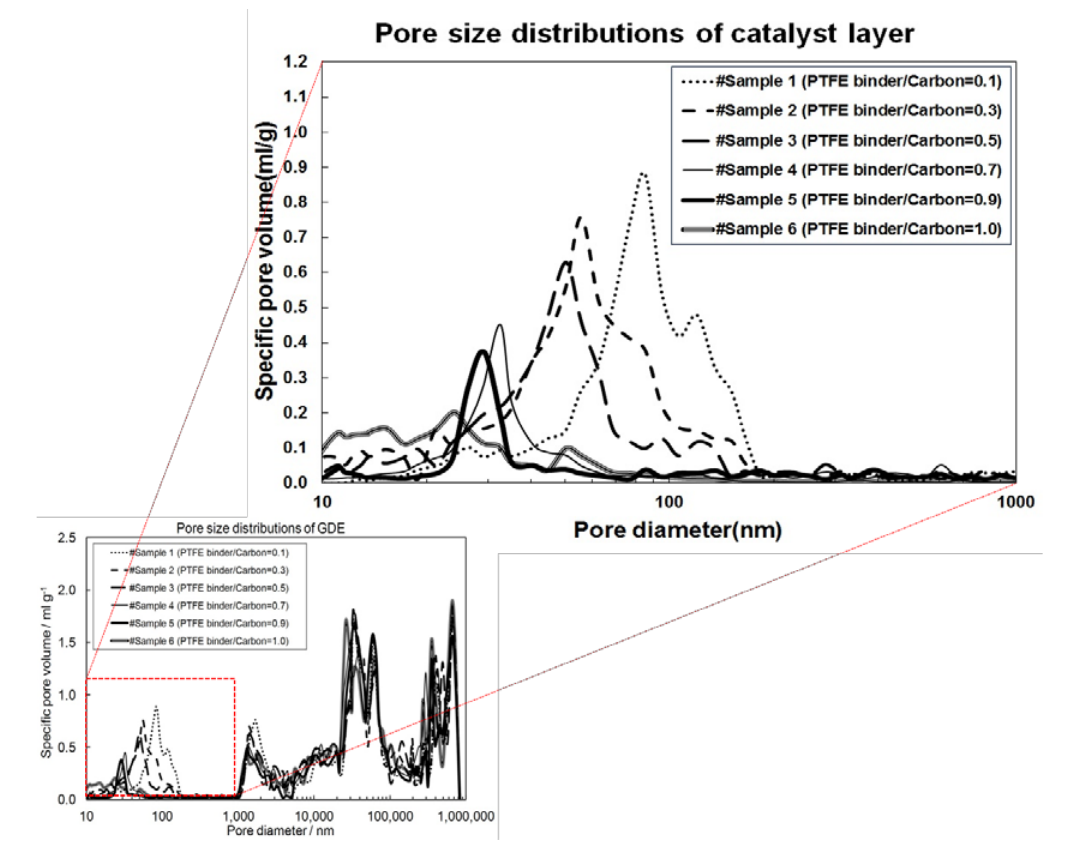
Figure 4. Pore size distribution of the gas diffusion electrode (GDE) (adapted from [28] with permission). Blow up shows the range from 0–1000 nm which is attributed to the catalyst